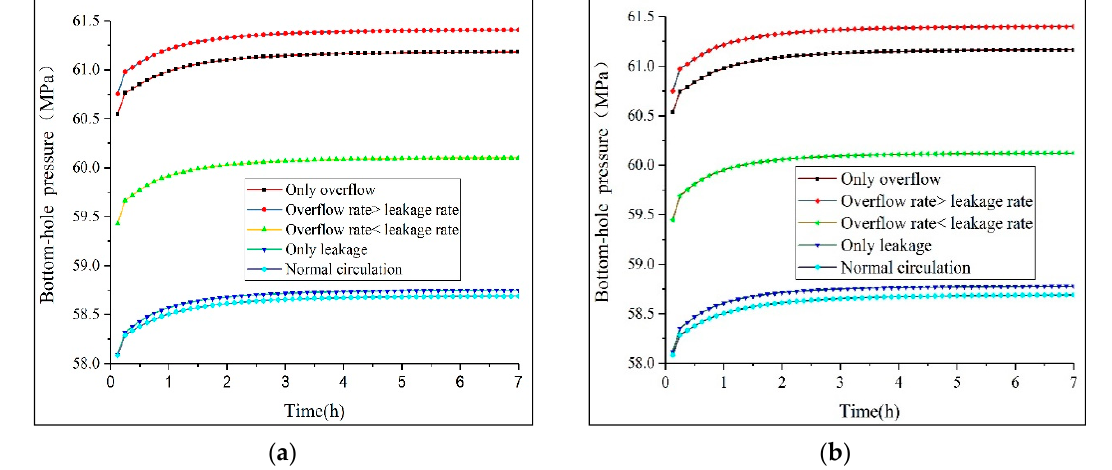
Figure 15. Variation of bottom-hole pressure at different overflow and leakage rates. ( a ) Variation of bottom-hole pressure when multi-pressure system is located in the middle formation; ( b ) Variation of bottom-hole pressure when multi-pressure system is located at bottom hole.